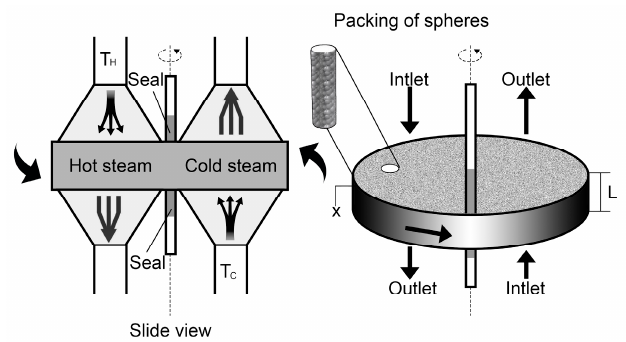
Figure 3. A schematic representation of the optimal rotary wheel [13] (redrawn by the authors) .